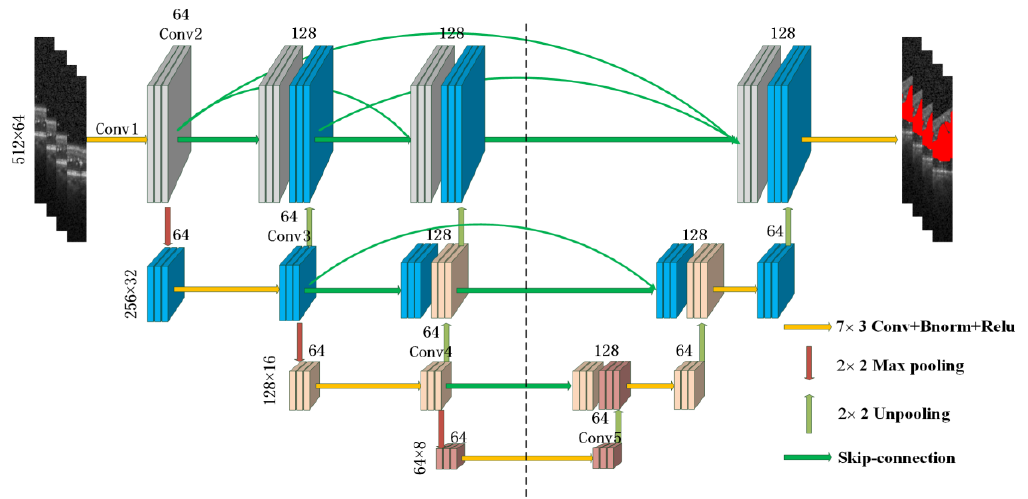
Appl. Sci. 2020 , 10 , x FOR PEER REVIEW Figure 5. Improved U-Net++ network. Figure 5. Improved U-Net ++ network.